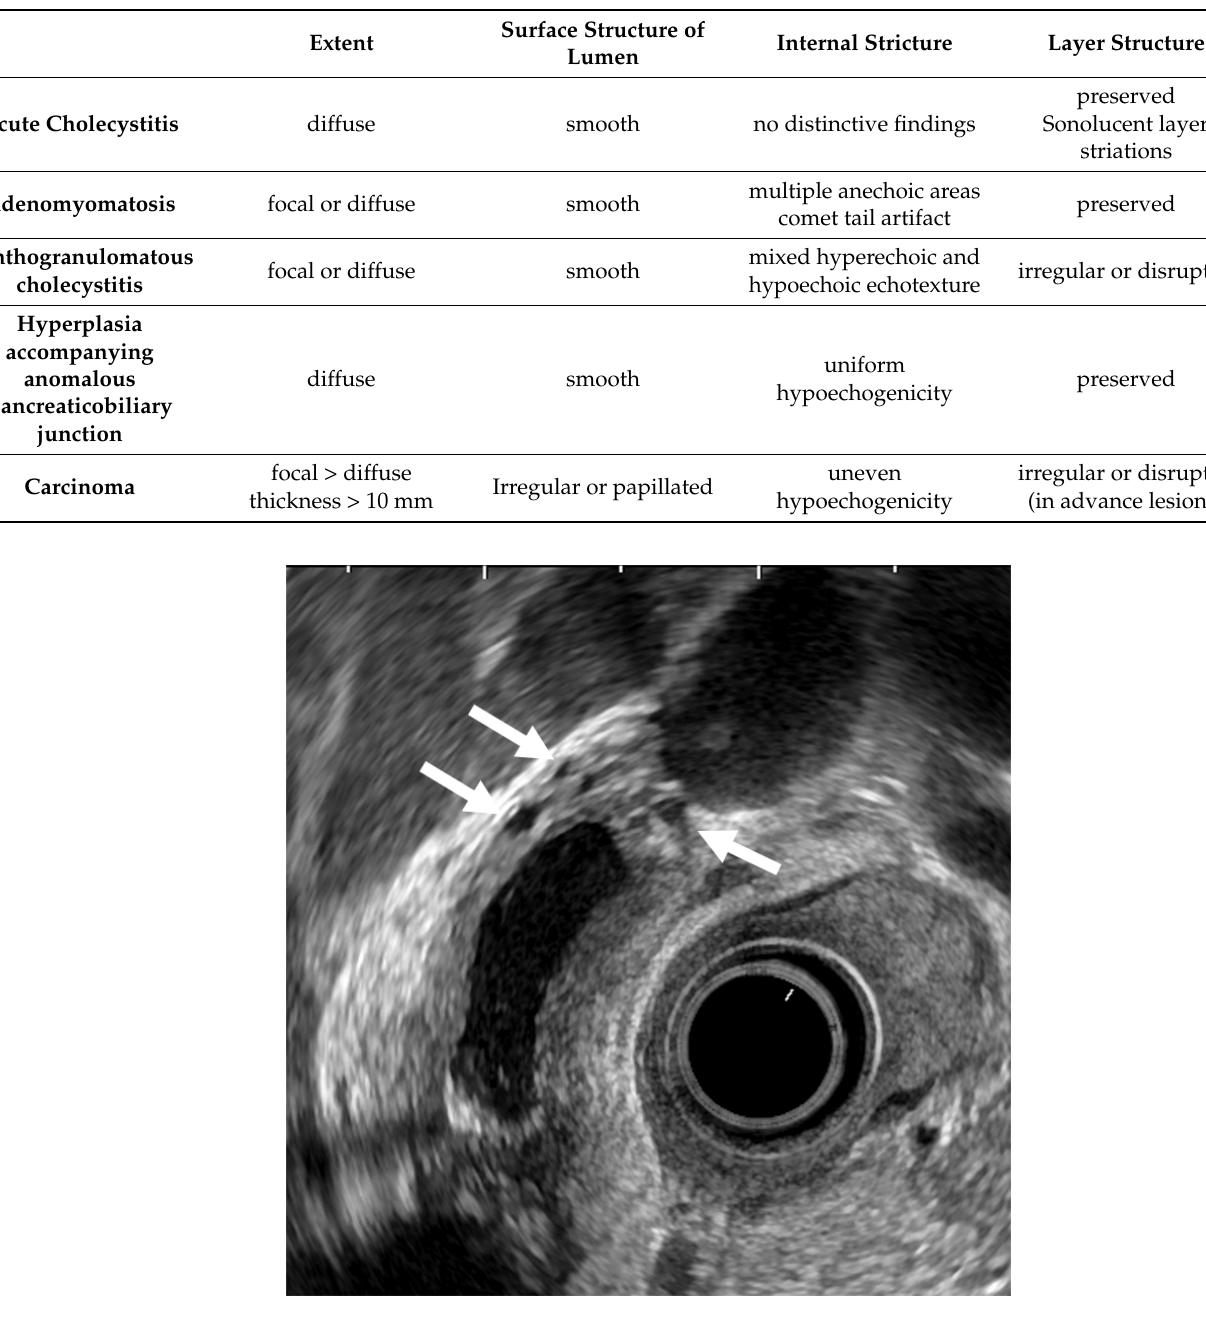
changes. In addition, imaging findings resemble those of GB carcinomas. EUS can